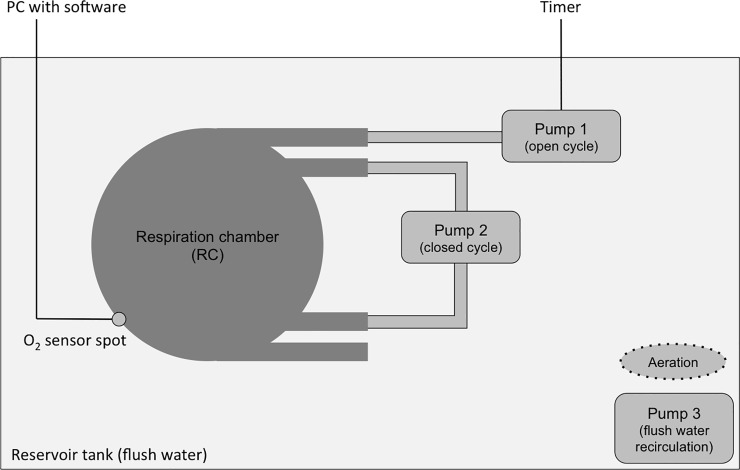
Schematic representation of the experimental setup.The oxygen concentration within the respiration chamber (RC) was continuously monitored using optical fibres connected to oxygen sensor spots. Pump 1 flushed the RC with aerated reservoir water in constant time intervals controlled by a timer. Pump 2 provided constant water circulation within the RC during the whole experimental period. Up to four RC were placed simultaneously into the reservoir tank. Pump 3 ensured water circulation in the reservoir tank to provide similar flush conditions for all RC. The reservoir tank provided space for maximum four RC in parallel. Modified after [41].